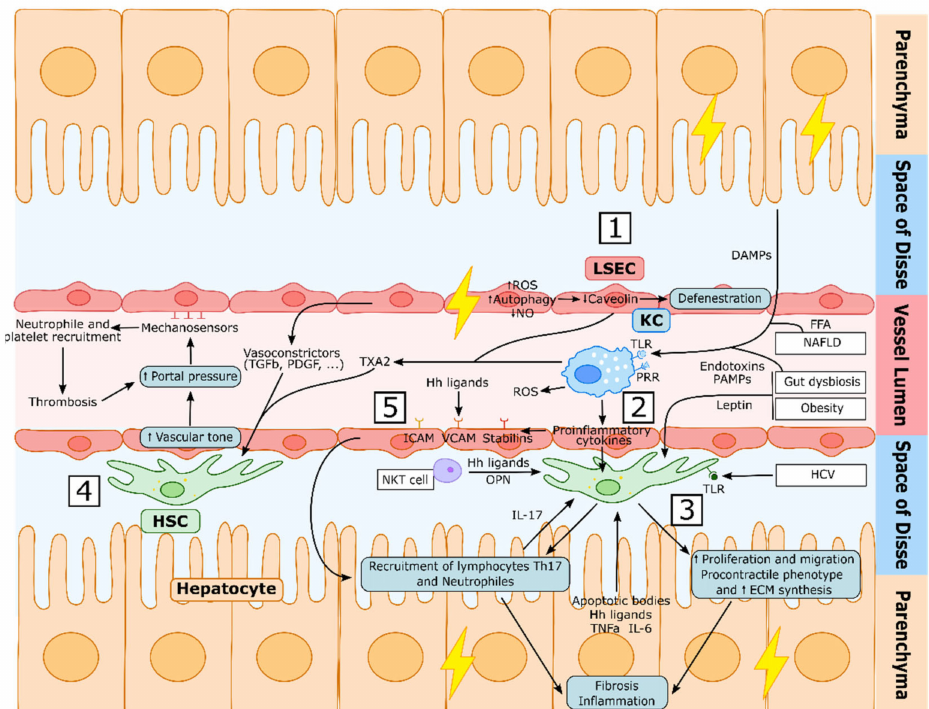
Figure 3. Liver Sinusoid dysfunction during chronic liver disease. ( 1 ) During chronic liver injury, LSEC become dysfunctional, impairing the autophagy process, increasing the generation of reactive oxygen species (ROS), decreasing nitric oxide (NO) intrahepatic levels and synthetizing increased vasoconstrictors, which induces the activation of HSCs. Hepatic damage further induces LSECs defenestration through the degradation of caveolin-1. ( 2 ) Kupffer cells (KCs) are activated by damage- associated molecular patterns (DAMPs), pathogen-associated molecular patterns (PAMPs), free-fatty acids (FFA) and endotoxins via their toll-like receptors (TLR) and pattern recognition receptors (PRR). This induces the secretion of reactive oxygen species (ROS) and proinflammatory cytokines that, together with other proinflammatory molecules secreted by other cell types, activate HSCs ( 3 ) which will acquire a proliferative, migrating, procontractile and proinflammatory